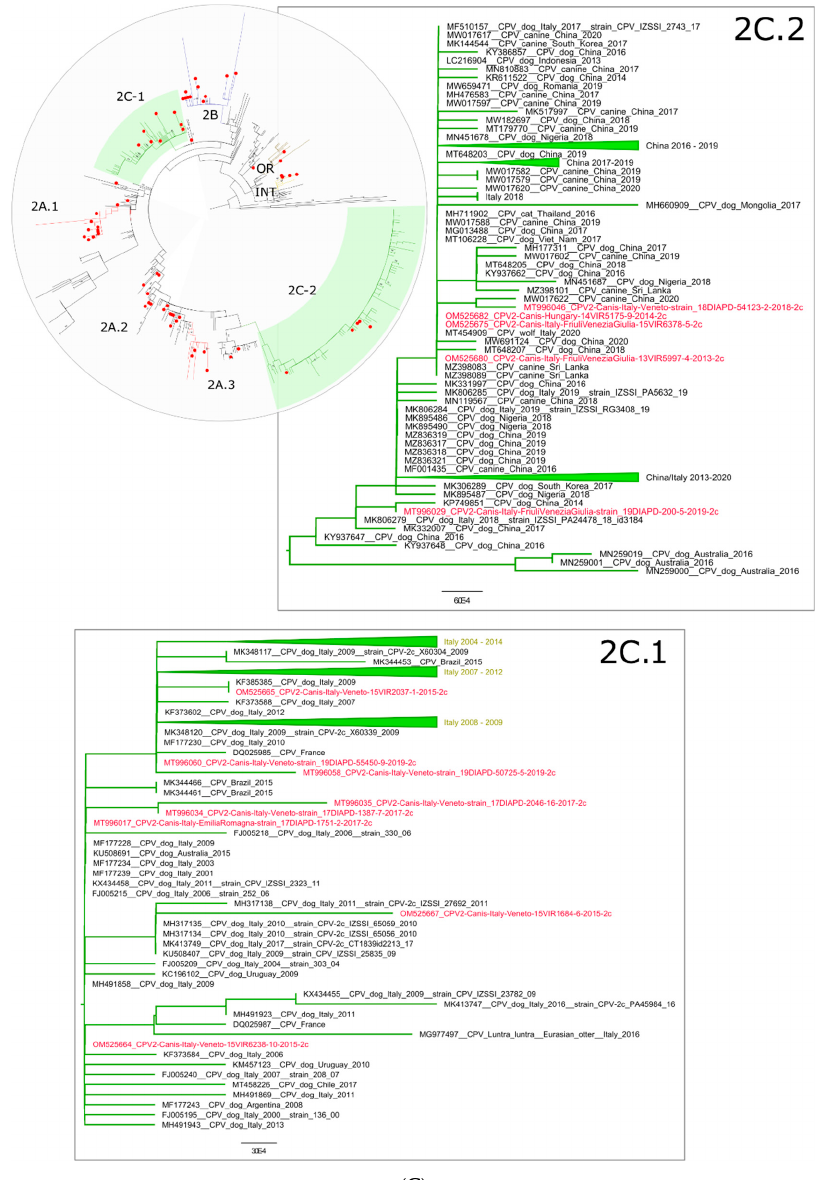
Figure 3. ( A ) Circular phylogenetic tree of the VP2 nucleotide sequences of CPV-2 identified in the present study (identified with a red dot) and similar CPV-2 strains available in GenBank. Groups 2A.1, 2A.2 and 2A.3 were highlighted in the circular tree and magnified in rectangular boxes. The IZSVe CPV-2 strains are highlighted in red. ( B ) Circular phylogenetic tree of the VP2 nucleotide sequences of CPV-2 identified in the present study (identified with a red dot) and similar CPV-2 strains available in GenBank. Groups 2B, OR and INT were highlighted in the circular tree and magnified in rectangular boxes. The IZSVe CPV-2 strains are highlighted in red. ( C ) Circular phylogenetic tree of the VP2 nucleotide sequences of CPV-2 identified in the present study (identified with a red dot) and similar CPV-2 strains available in GenBank. Groups 2C.2 and 2C.1 were highlighted in the circular tree and magnified in rectangular boxes. The IZSVe CPV-2 strains are highlighted in